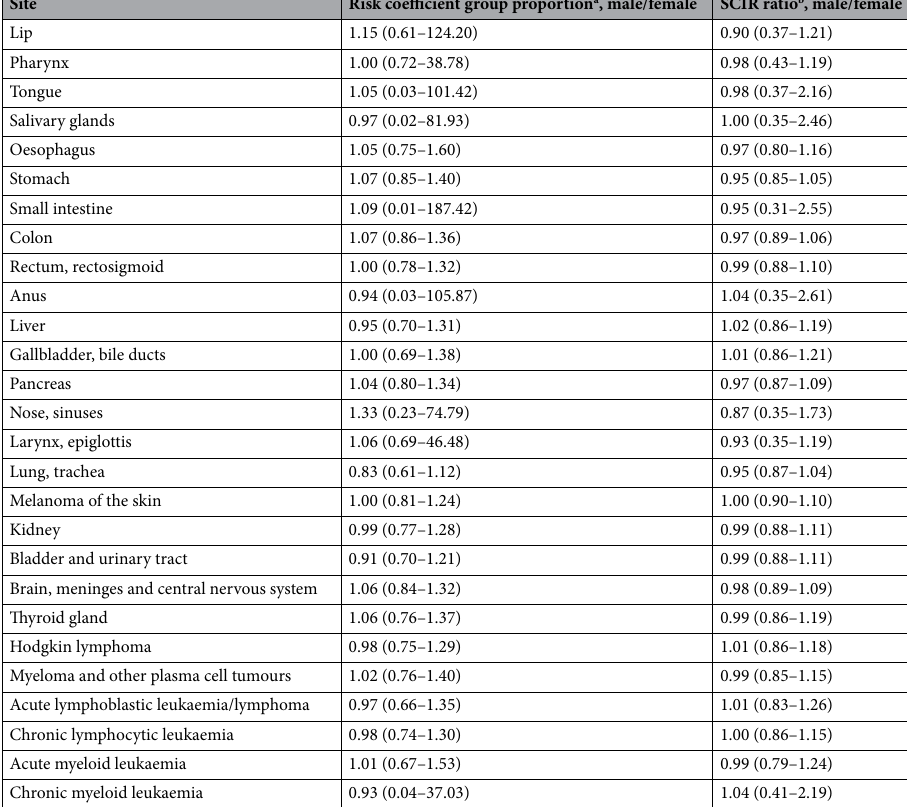
Table 2. Male–female ratios of risk coefficient group proportions and standardised cumulative incidence ratios by cancer site from 1956 to 2016. Male–female ratios of risk coefficient group proportions and standardised cumulative incidence ratios, with 95% posterior credible intervals given in parentheses, by cancer site. a Proportion of municipality-name-sex combinations for which a higher risk coefficient was used during a sampling step. b Standardised cumulative incidence ratio in higher risk coefficient municipality-name-sex combinations over standardised cumulative incidence ratio in all municipality-name-sex